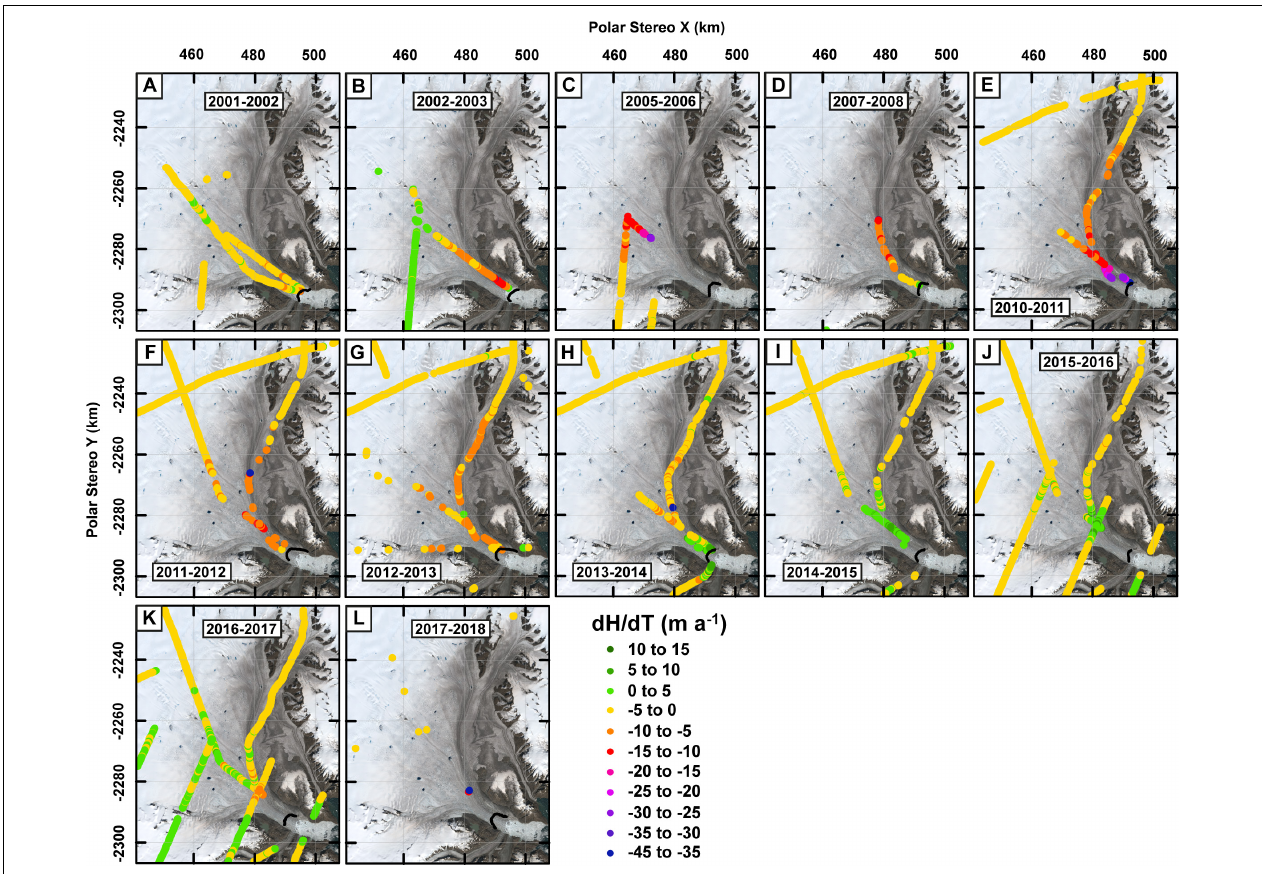
FIGURE 6 | Annual surface elevation change for Kangerlussuaq between 2001 and 2018 from Operation IceBridge ATM data. Panels relate to surface elevation change for the time periods 2001–2002 (A) , 2002–2003 (B) 2005–2006 (C) , 2007–2008 (D) , 2010–2011 (E) , 2011–2012 (F) , 2012–2013 (G) , 2013–2014 (H) , 2014–2015 (I) , 2015–2016 (J) , 2016–2017 (K) , and 2017–2018 (L) . The most retreated terminus position for the given time period is demarcated in black. Background image as in Figure 5